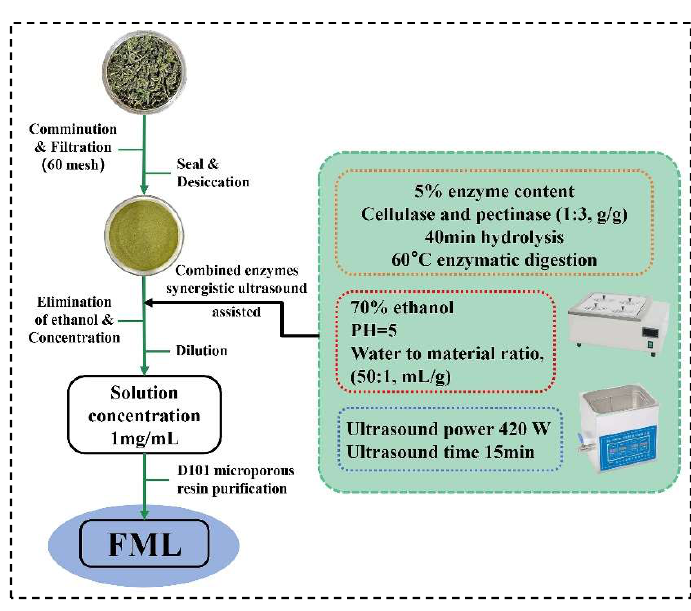
Figure 1. The procedure for the extraction and purification of FML.